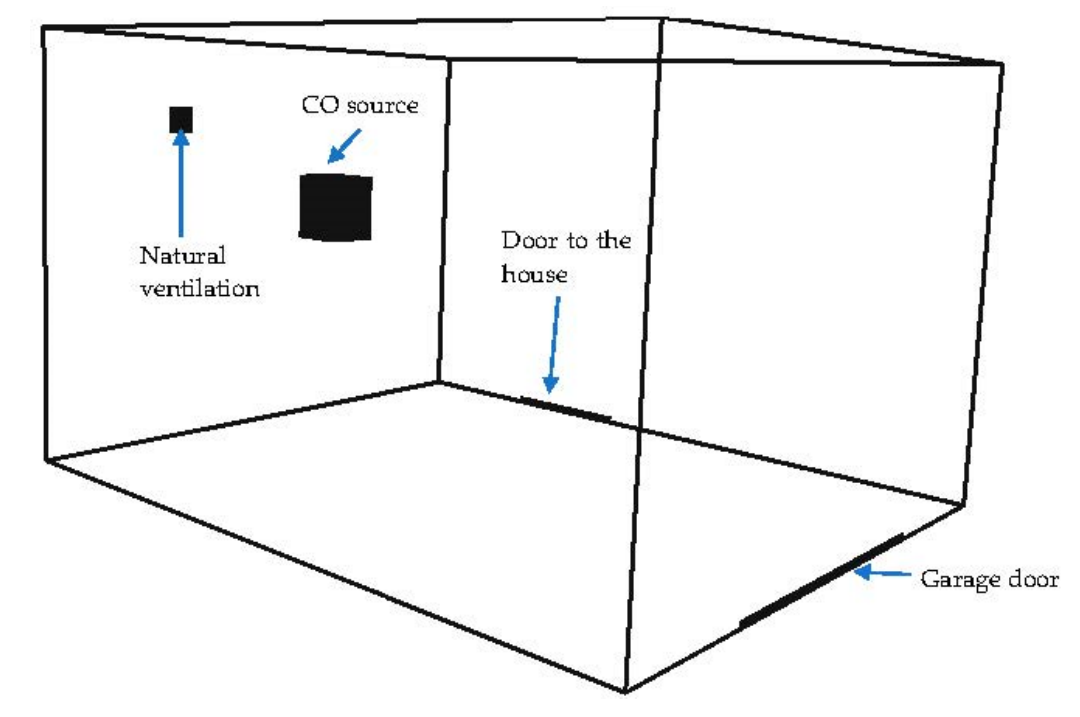
Figure 2. Computational fluid dynamics 0 (CFD0) wall frame of the garage.